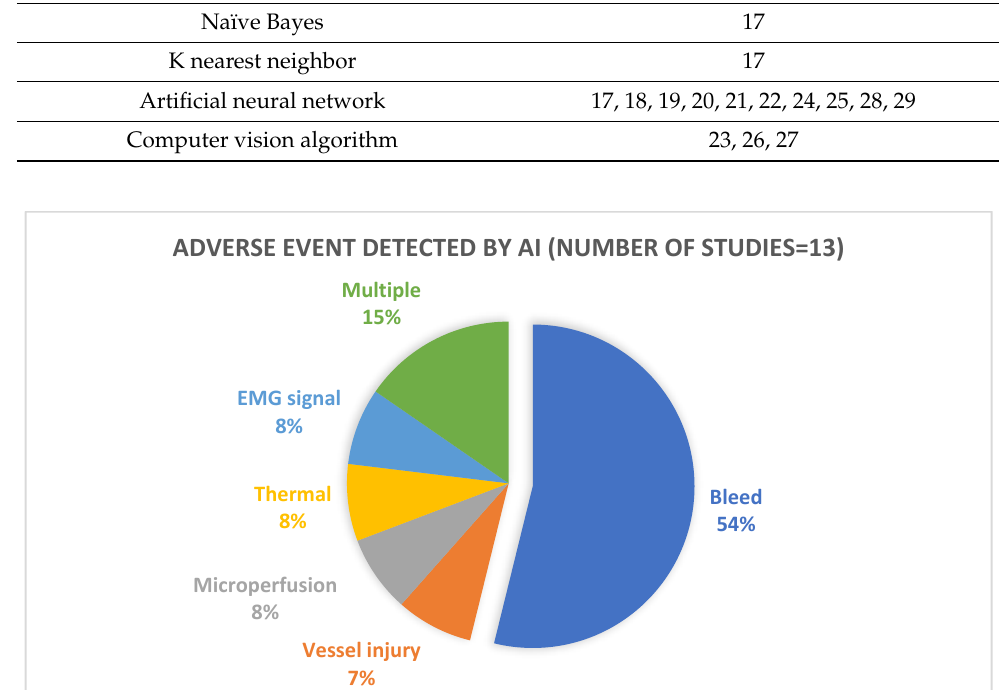
Figure 2. Intraoperative adverse event type identified by artificial intelligence (AI).